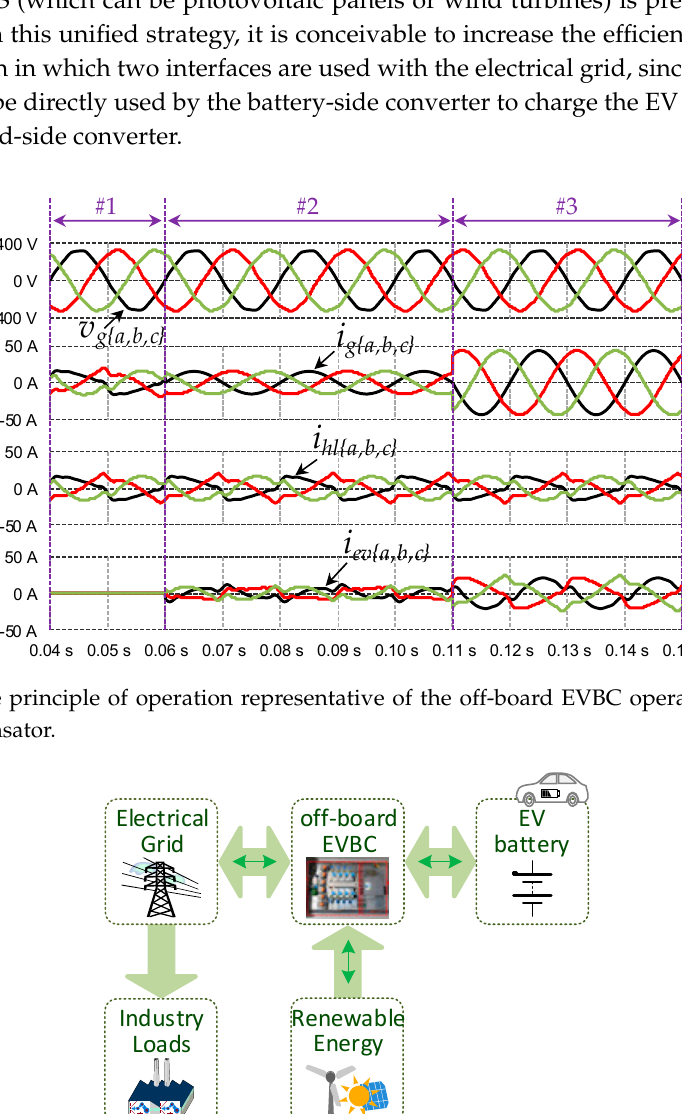
Figure 16. The principle of operation representative of the off-board EVBC operation as a power quality compensator.